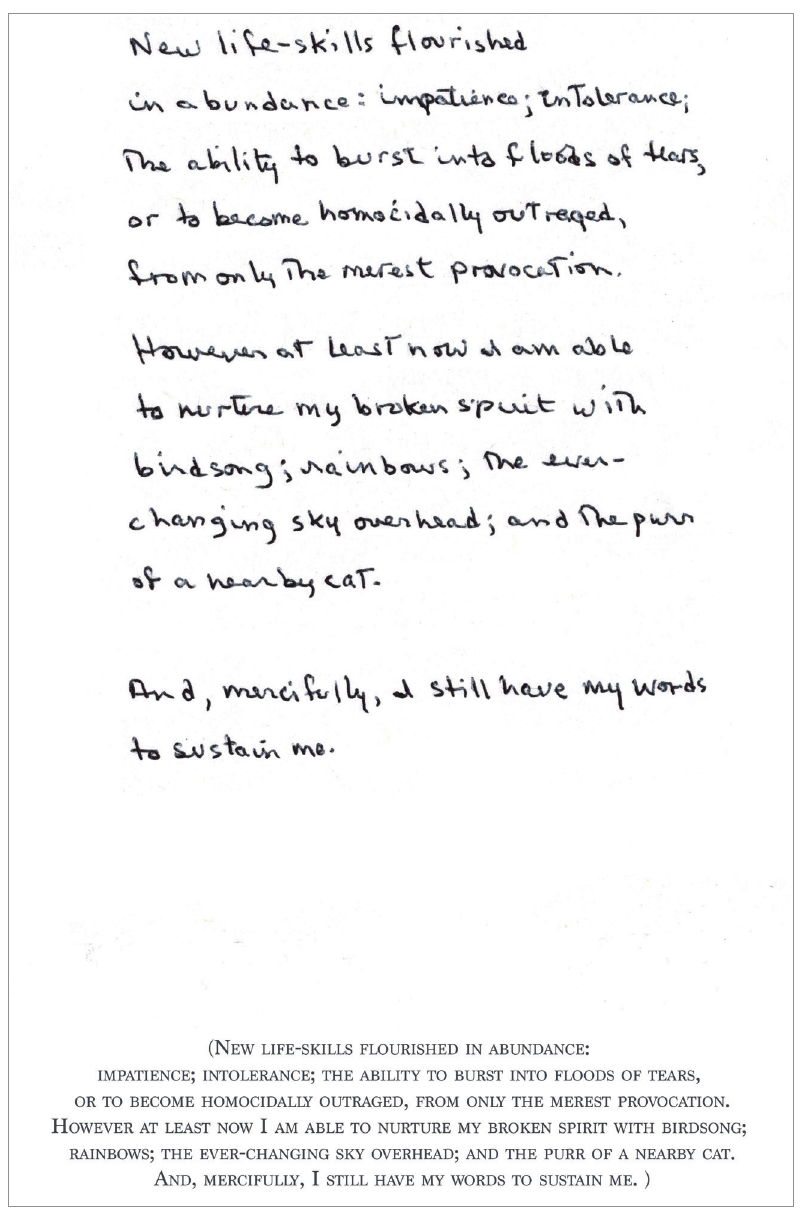
Figure 5: A handwritten image by a stroke survivor from the series ‘Different